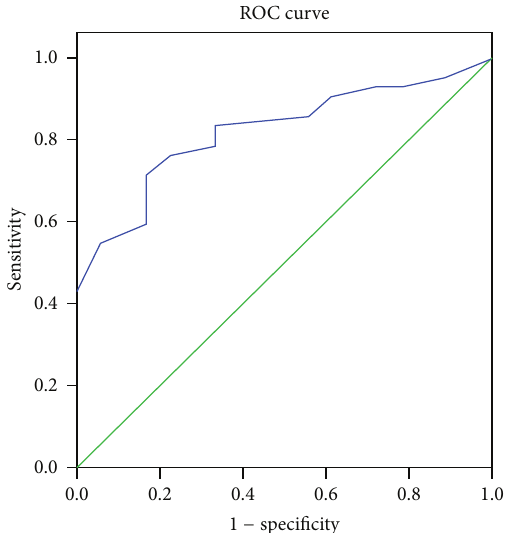
Figure 1: Diagonal segments are produced by ties. Roc Curve for AS, Aut./PDDNOS versus mixed